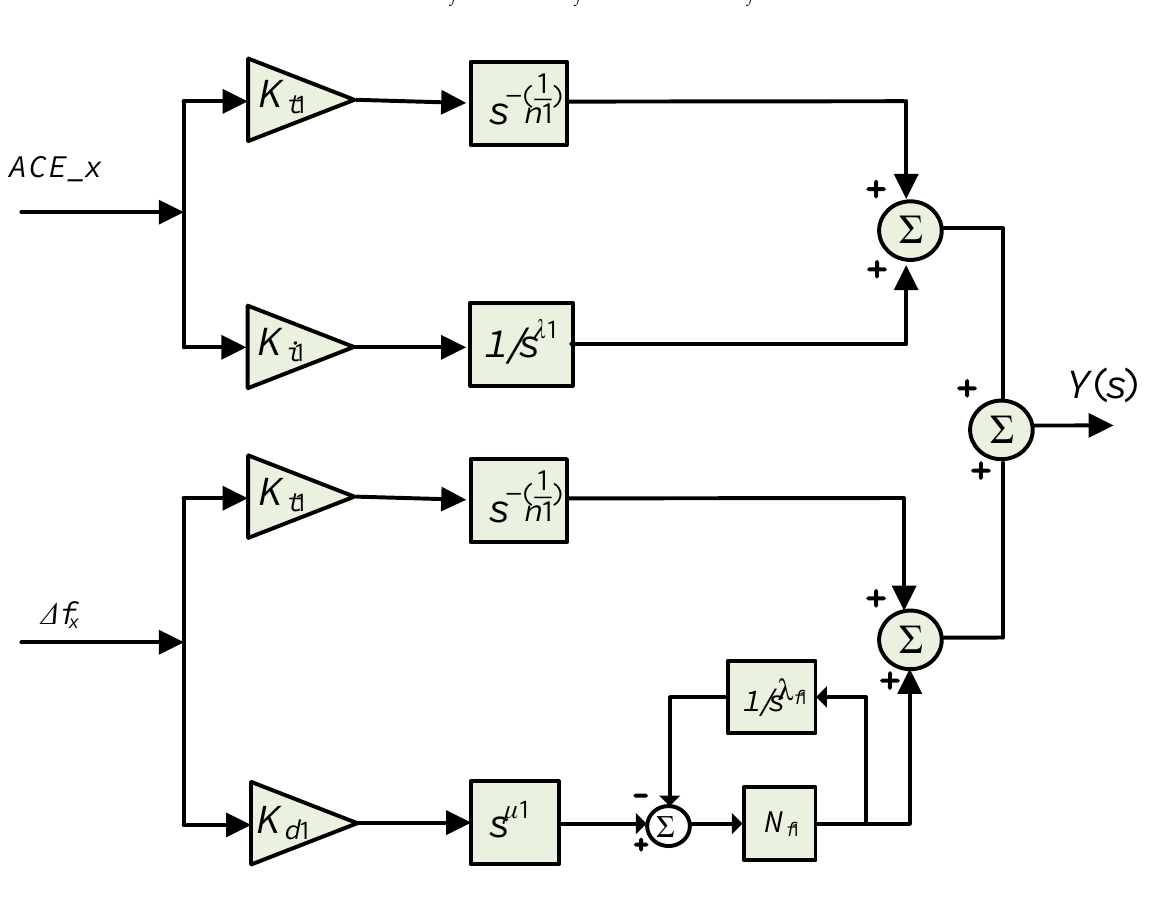
Figure 5. The structure of the proposed TFOI-TFODFF LFC